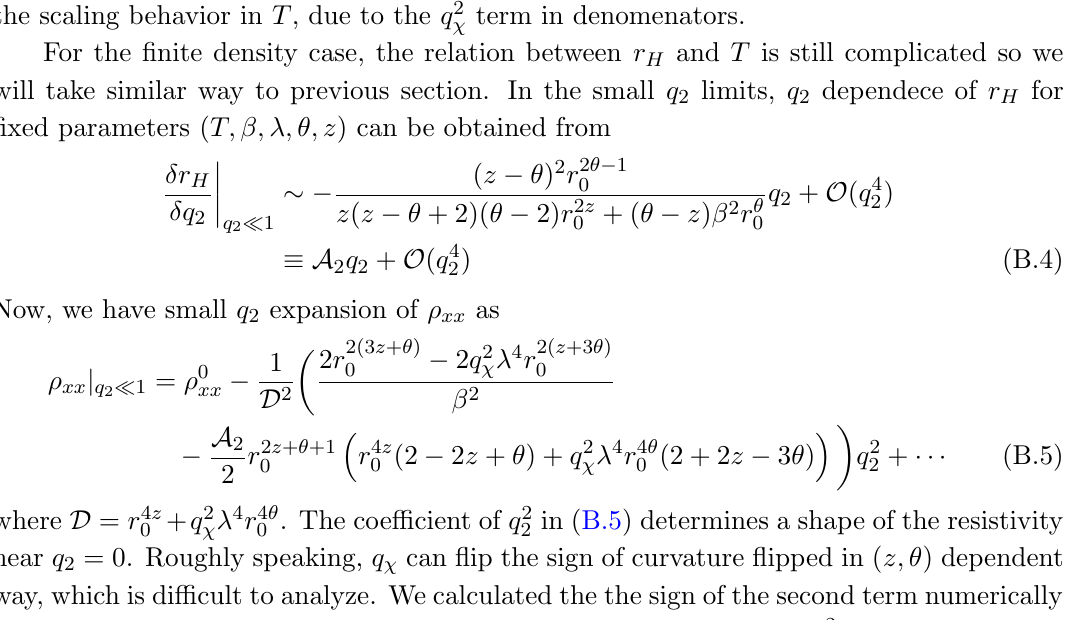
Figure 17 . Scaling behavior of (cid:27) xx ( q 2 ) at large q 2 and T = 10. (a) z -evolution of (cid:27) xx ( q 2 ) at (cid:18) = 0. (b) log-log plot of (a), (c) (cid:18) -evolution of (cid:27) xx ( q 2 ) at z = 1. (d) log-log plot of (c), (e) The exponent (cid:13) of (cid:27) xx ( q 2 ) j q (cid:24) q (cid:13) for various ( z; (cid:18) ). Whenever z = (cid:18) , the value of (cid:13) is discontinuous, which is 2 2 !1 indicated by empty circles in the (cid:12)gure. At all the empty circle points, (cid:13) = 2 which is discontinuous value from its neighboring point. Here, we analyzed this only in Phase A and B. (f) When z = 2, (cid:13) = 2 independent of (cid:18) , which is indicated by yellow line in (e). where r 0 is r H ( q 2 = 0). Di(cid:11)erent from electric conductivity, the resistivity does not